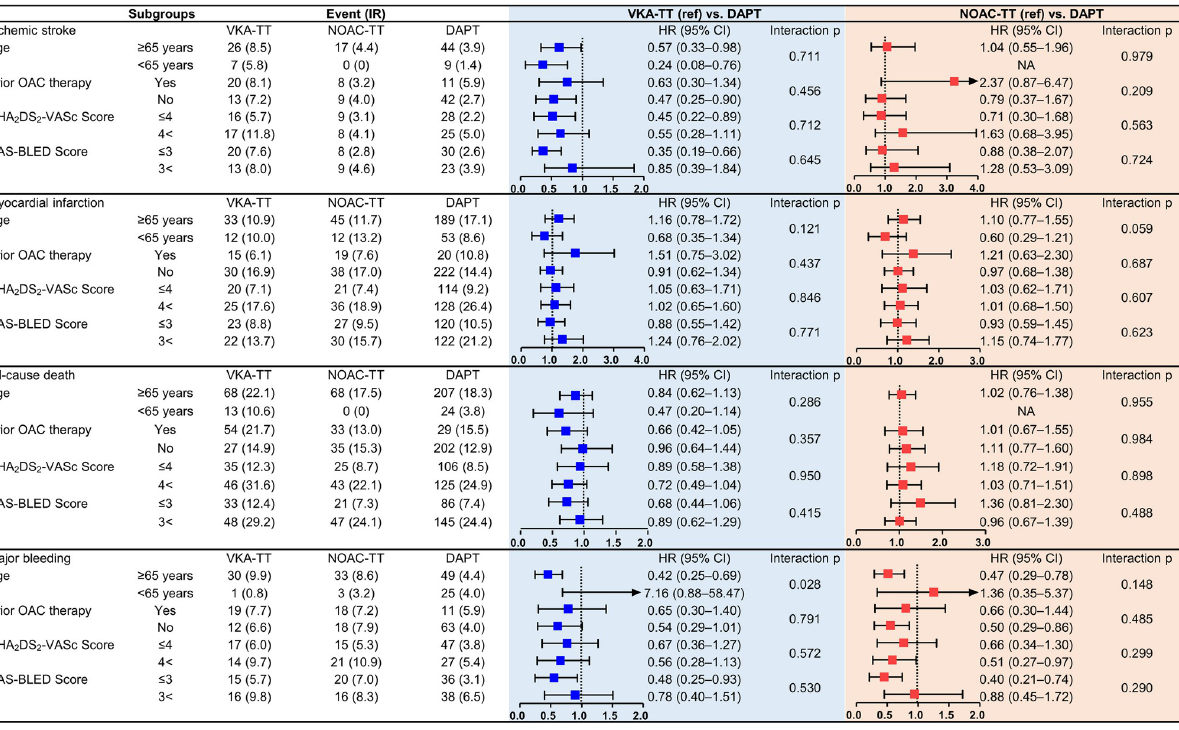
Fig 4. Subgroup analysis for clinical outcomes according to antithrombotic therapy. Prespecified subgroup analysis was performed in elderly patients (age > 65 years), those with potent P2Y 12 inhibitors (prasugrel or ticagrelor), according to prior OAC treatment, and after patient stratification according to their baseline stroke and bleeding risks. The incidence rate was expressed as the number of events per 100-person year. The HR was estimated after the adjustment for baseline characteristics. CI, confidence interval; DAPT, dual antiplatelet therapy; HR, hazard ratios; IR, incidence rate; NOAC-TT, non-vitamin K oral anticoagulant-based triple therapy; OAC, oral anticoagulants; VKA-TT, vitamin K antagonist-based triple therapy.